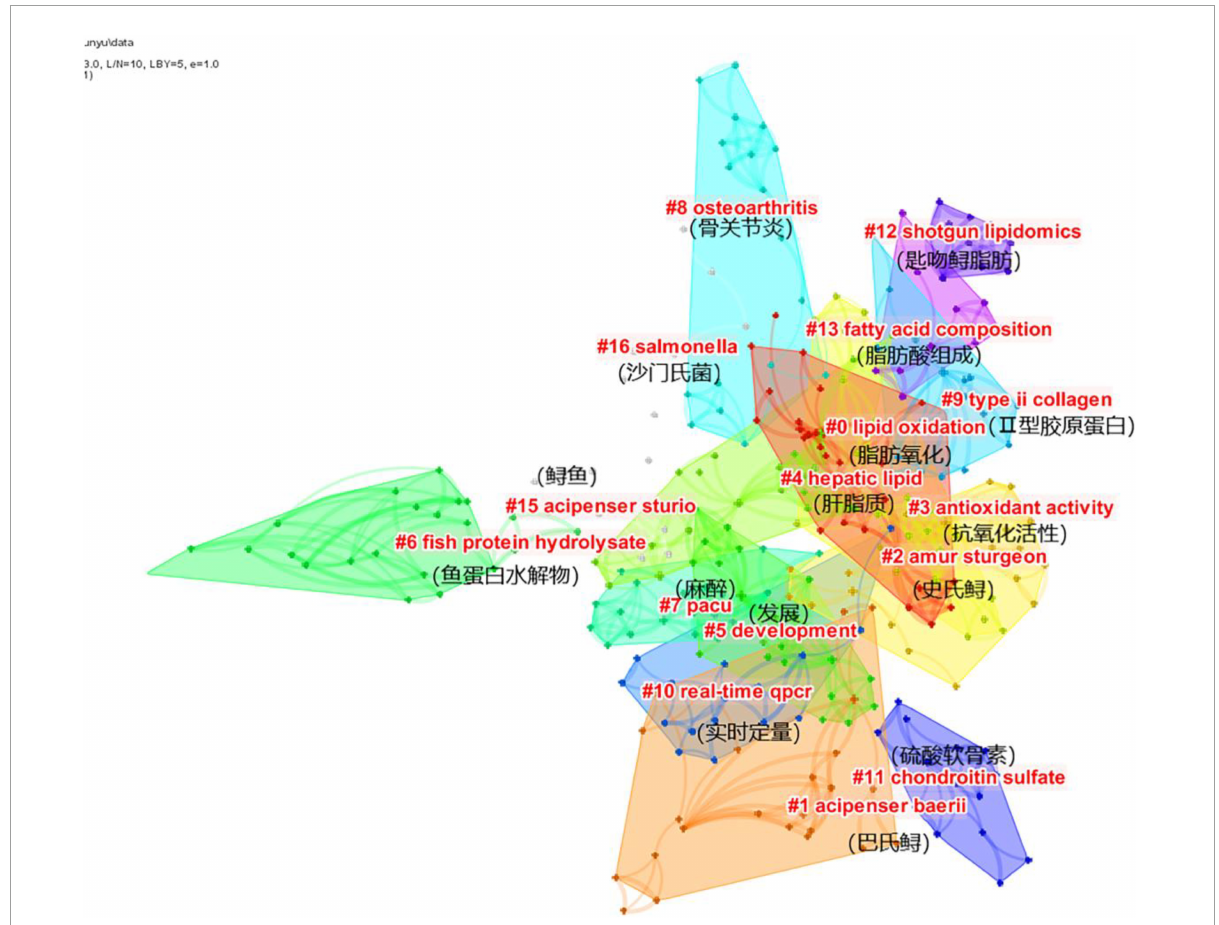
FIGURE6 Clustering map of deep sturgeon processing.